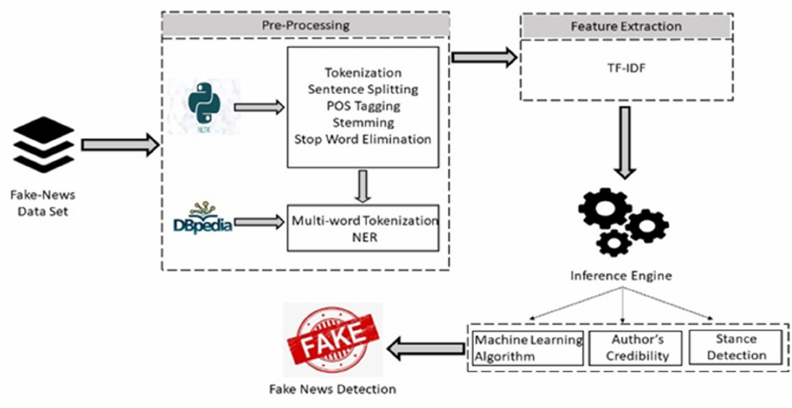
Figure 2. Fake news detection